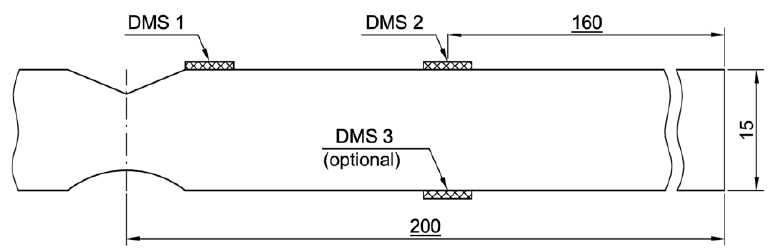
Figure 4. Schematic presentation of the specimen geometry for series 1–17 including the strain gauge positions to detect crack initiation and misalignment-related secondary bending stresses, adapted from [37] .